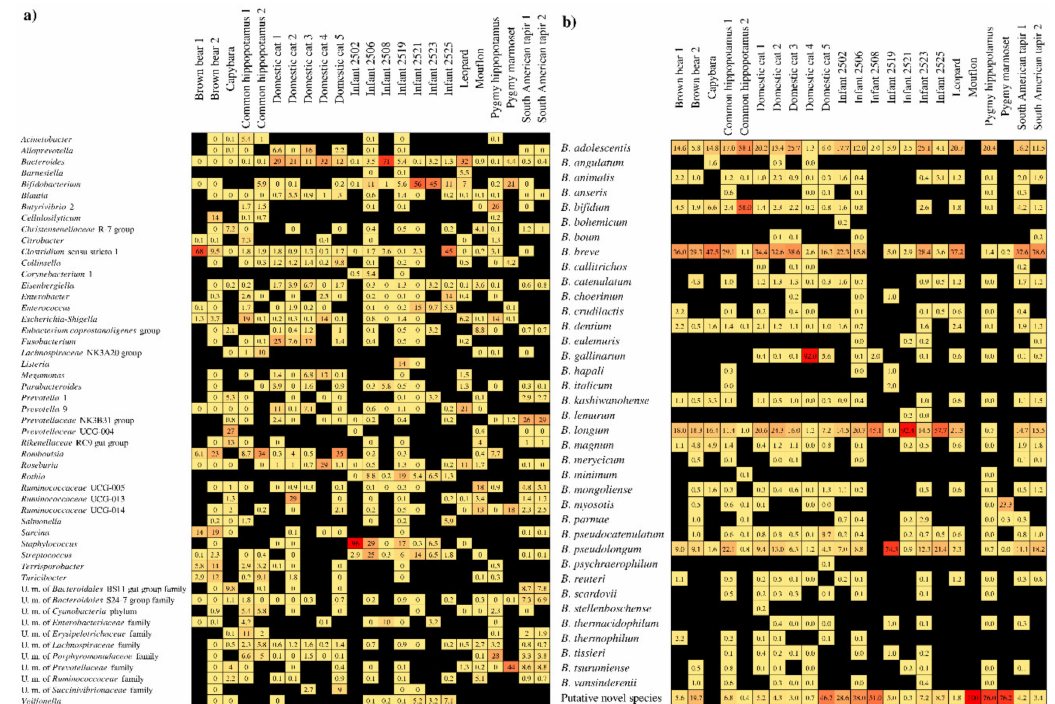
Figure 1. Bifidobacterial profiling of 23 fecal samples of human and animals. Panel ( a ) displays the relative abundance of each genus by means of 16S rRNA microbial profiling. Only genera that display at least one sample with a relative abundance of at least 5% were included in the heat map. Panel ( b ) shows the relative abundance of each species belonging to the genus Bifidobacterium by means of ITS bifidobacterial profiling. Only species that display at least 0.01% of the total amount of the sequencing data were included in the heat